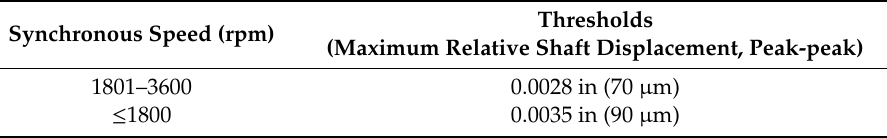
Table 3. Thresholds by Std. NEMA MG ‐ 1.